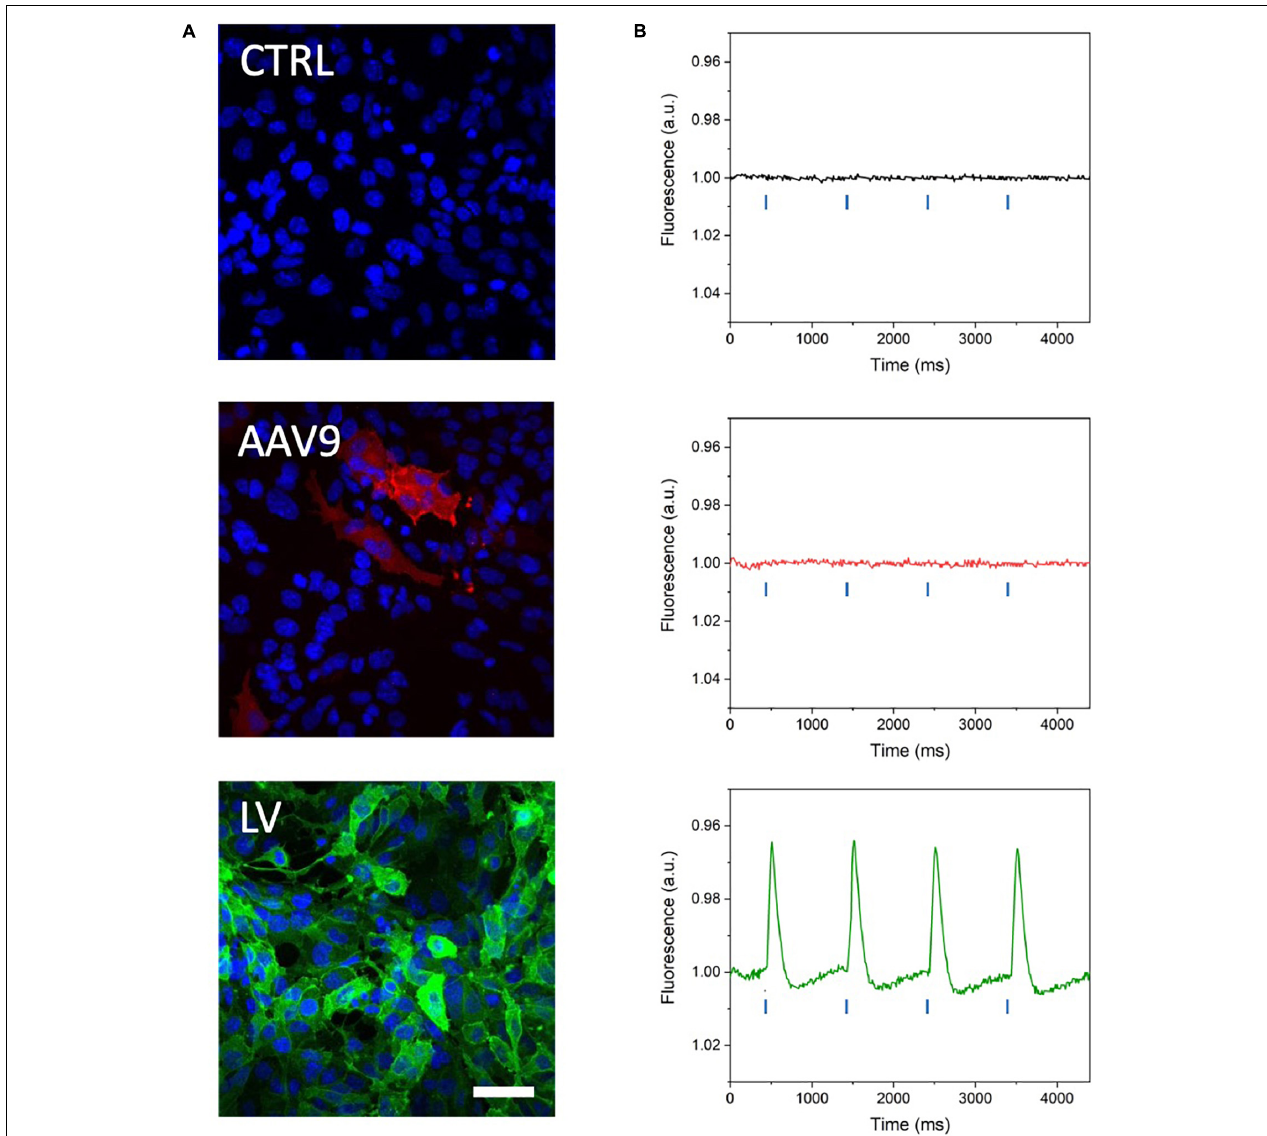
FIGURE 3 | Optical recording of optogenetically induced APs in channelrhodopsin-expressing HL-1 cells. (A) Representative confocal microscope images of HL-1 cells expressing blue light-activable ion channels after transduction with a commercial AAV serotype capsid 9-pseudotyped AAVV encoding mCherry-tagged ChR2(H134R) (red channel) and a custom-made vesicular stomatitis G protein-pseudotyped LV encoding eGFP-tagged CheRiff expression (green channel). Cell nuclei were stained with DAPI (blue channel). The higher eGFP signal attests to the more efficient transduction of the HL-1 cells with the LV than with the AAVV. Scale bar = 25 µ m. (B) Representative traces of optically induced APs registered in AAVV- and LV-transduced HL-1 cell layers after loading of the cells with VSD and stimulating with blue light pulses at 1 Hz (blue lines in the graph). Consistent with the higher transduction efficiency of the HL-1 cells, APs were registered only in the LV-transduced HL-1 cells. CTRL, untransduced HL-1